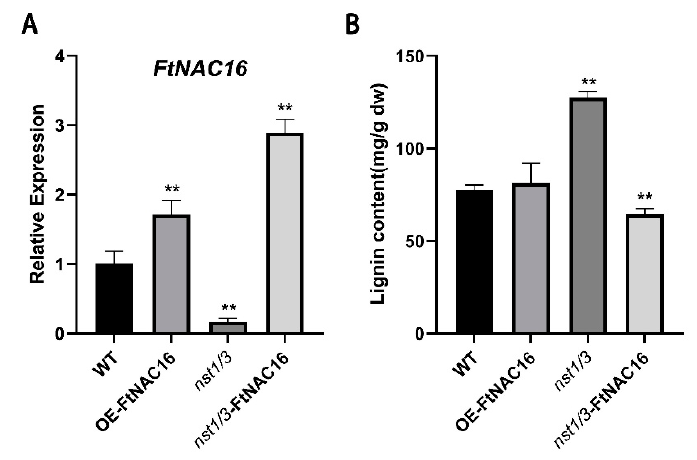
Figure 7. Effects of FtNAC16 expression on lignin synthesis under salt stress. ( A ) Relative expression of the FtNAC16 transcript in A. thaliana subjected to salt stress. ( B ) The content of lignin in the leaves of WT, OE-FtNAC16, nst1/3 and nst1/3 -FtNAC16 lines after salt stress. Significant differences are denoted by **, meaning p < 0.01.